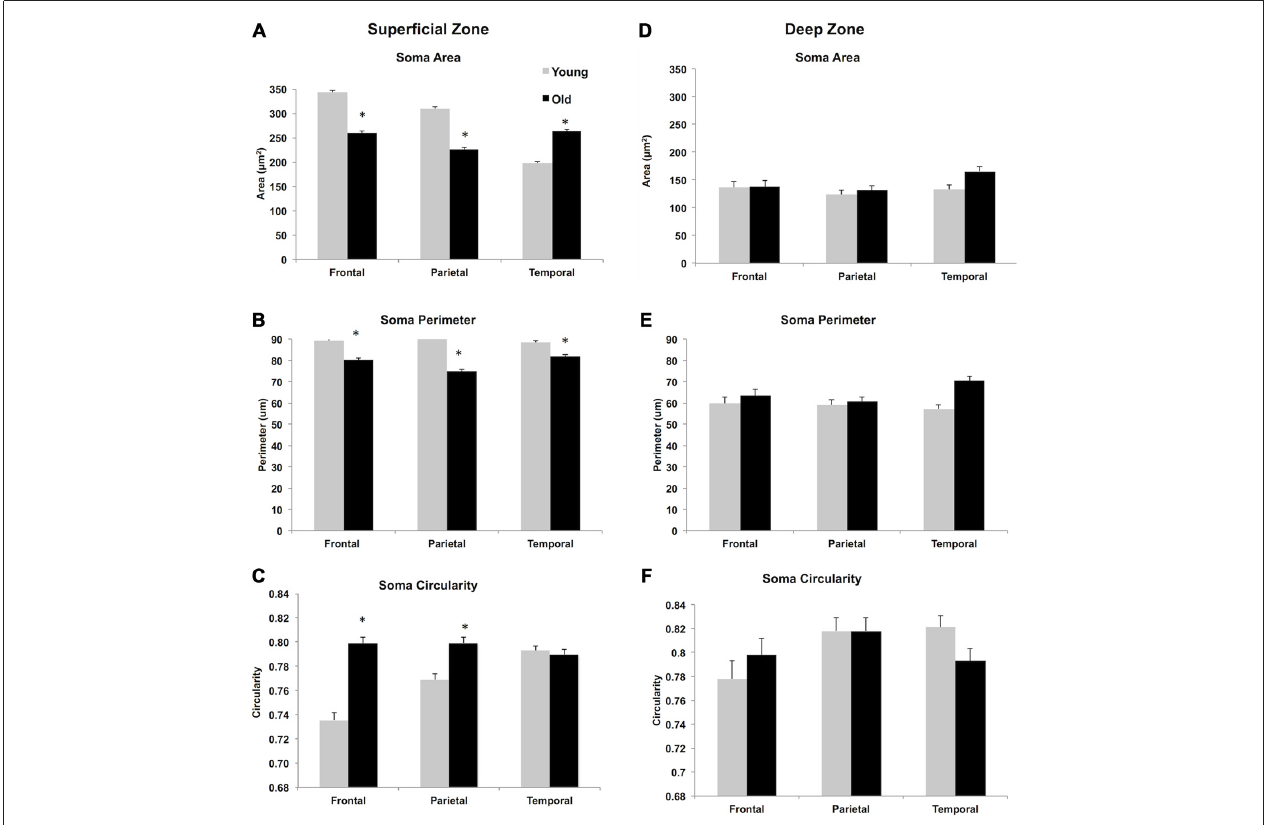
FIGURE 6 | Morphometric analysis of WMN in superficial (A–C) and deep zones (D–F) . The widest range in area and perimeter and shape was observed in superficial WMNs of the temporal lobe. In the deep white matter, neurons showed greater variability in size and shape in all three regions. ∗ p < 0.05, compared to young monkeys.